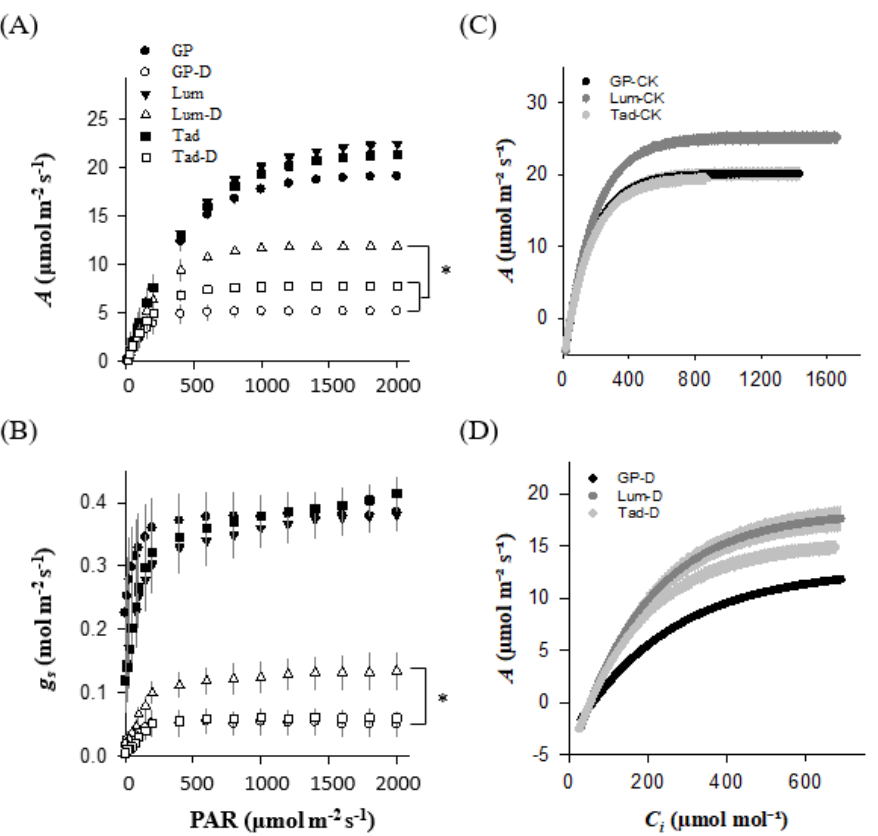
Figure 2. Photosynthetic curves for GP, Lum, and Tad. ( A , B ) Net photosynthesis ( A ) and stomatal conductance ( g s ) were measured by the light response curves, generated at a temperature of 25 ◦ C, RH of 60%, and 400 µ mol mol –1 C a . ( C , D ) CO 2 response curves were generated at a temperature of 25 ◦ C, RH of 60%, and 2000 µ mol m − 2 s − 1 PAR. Data are presented as the means ± se ( n = 3–4). * indicates significant differences at p < 0.05. The apparent CO 2 compensation point, calculated from the A / C i curves, was